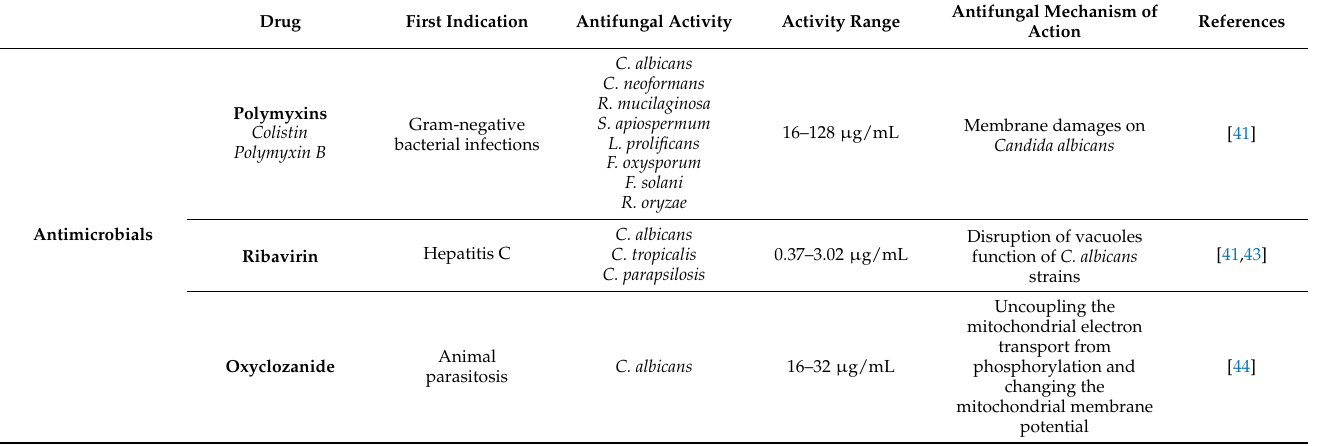
Table 2. Drugs with reported in vitro antifungal activities. NR: not